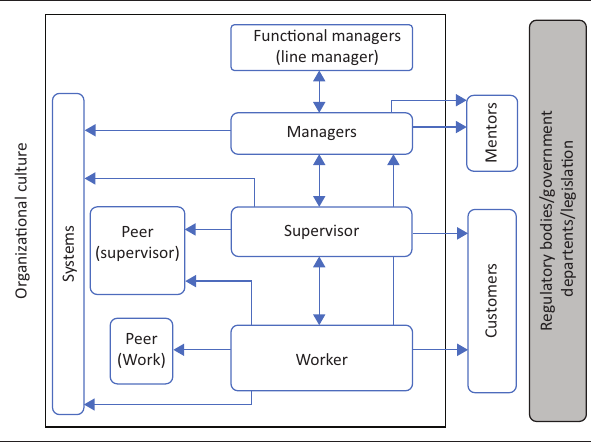
FIGURE 2: Conceptual accountability